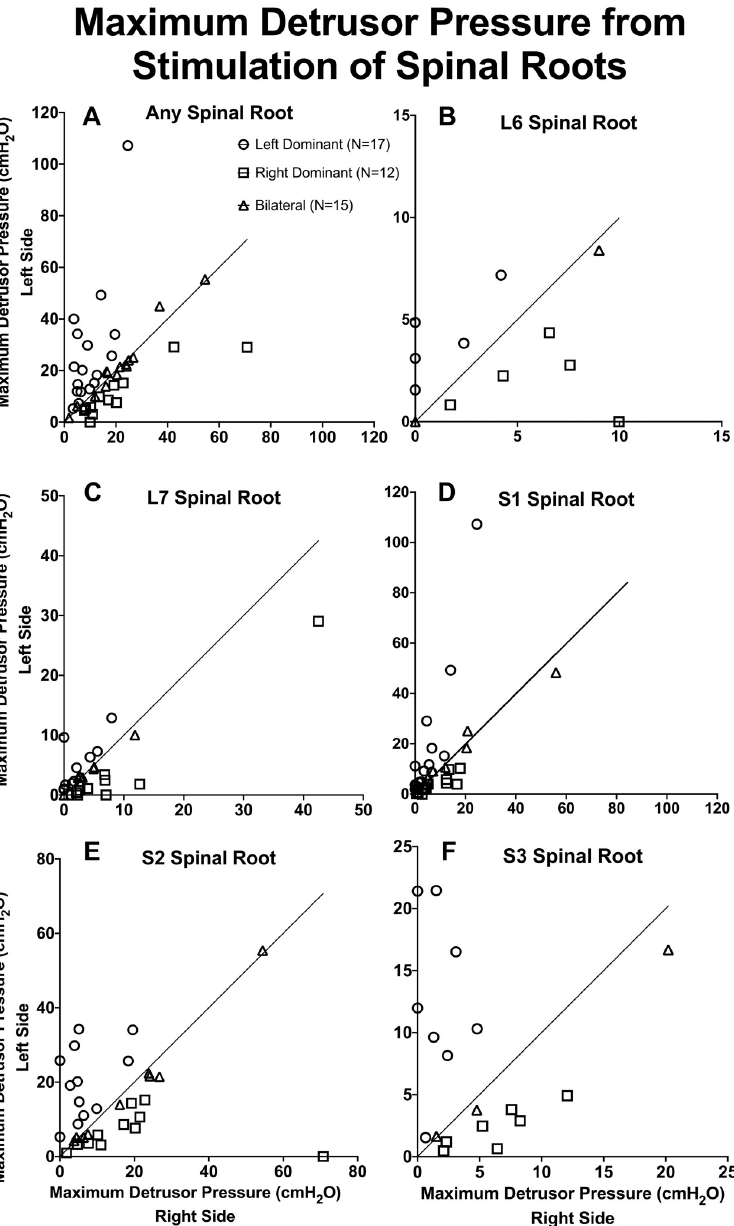
Fig 2. Maximum detrusor pressure after spinal root stimulation. A) Maximal contractions produced from electrical stimulation of L6 through S3 spinal roots were recorded during the initial surgeries in 44 of the 57 dogs. Left root- and right root-evoked contractions are displayed on the Y-axis and the X-axis, respectively. Each point represents the maximal contraction obtained from stimulation of either left or right spinal root in a single animal, whichever produced the strongest bladder contraction. B). Maximum detrusor pressure upon left and right L6 spinal root stimulations obtained from 12/44 dogs. C). Maximum detrusor pressure upon left and right L7 spinal root stimulation obtained from 28/44 dogs. D). Maximum detrusor pressure upon left and right S1 spinal root stimulation obtained from 36/44 dogs. E). Maximum detrusor pressure upon left and right S2 spinal root stimulation obtained from 32/44 dogs. F). Maximum detrusor pressure upon left and right S3 spinal root stimulation obtained from 18/44 dogs. L = Lumbar, S = Sacral, N = number of dogs, cmH 2 O = centimeter of water.